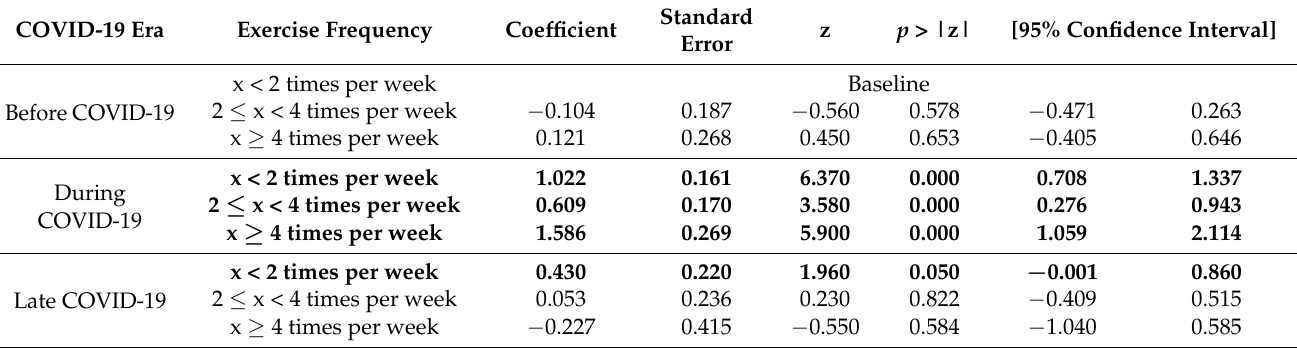
Table 3. The effect of the COVID-19 era and exercise frequency on mental distress among women.